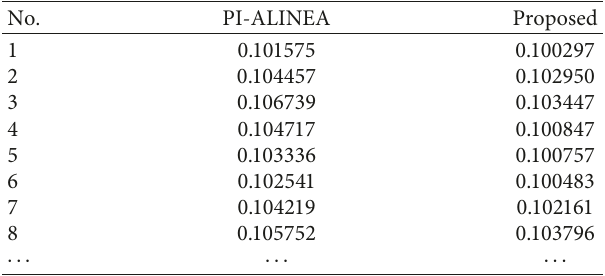
Table 5: Partial real-time collision rate of different strategies.